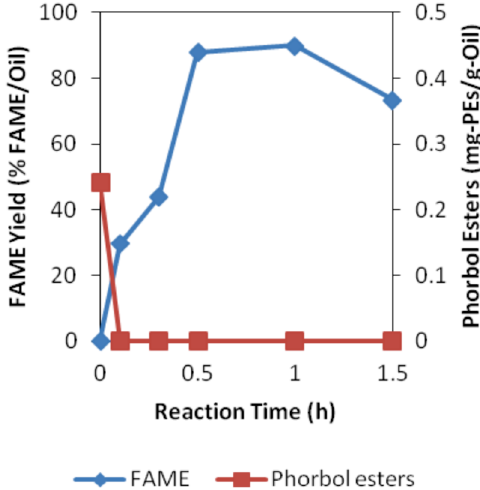
Fig. 4. Time course of phorbol esters in reaction products in acid catalyzed transesteri fi